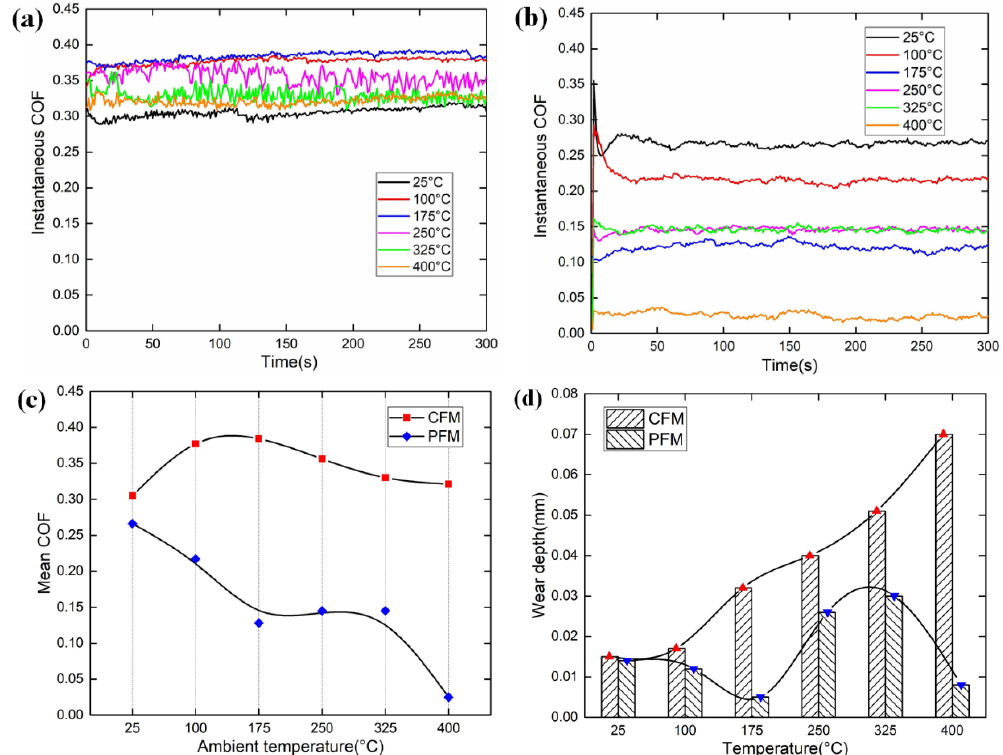
Figure 7. Experimental results under the ambient temperature condition. ( a ) Instantaneous COF of CFM; ( b ) instantaneous COF of PFM; ( c ) mean COFs of the CFM and PFM; ( d ) wear depths of the CFM and PFM.